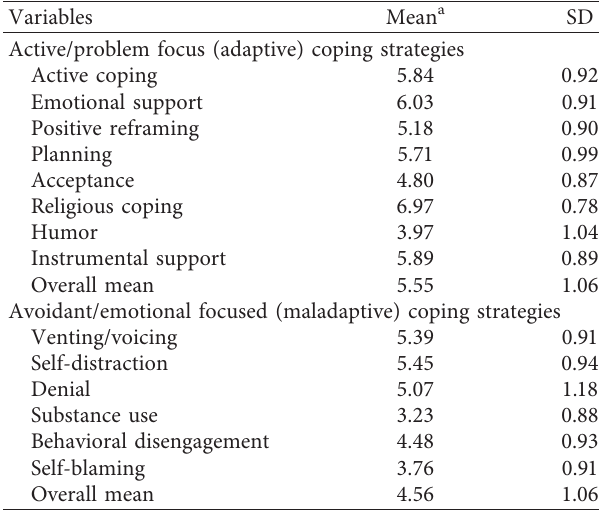
Table 3: Mean and standard deviation of coping strategies of women diagnosed with breast